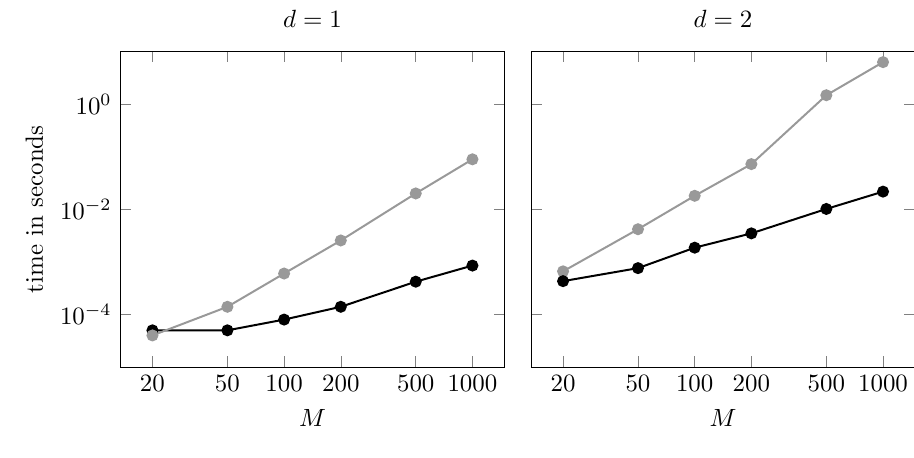
Figure 1: Computation performance. The time in seconds to compute the loss probability mass function is displayed against the loss support size M for the discrete Fourier transform (black line) and recursive (grey line) methods. The one-factor (left panel) and two-factor (right panel) standard Gaussian copula have been used under the assumption of constant loss given default.